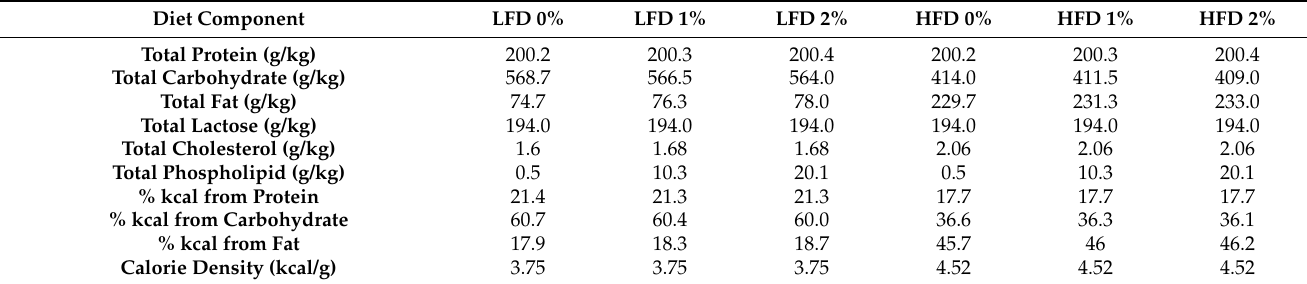
Table 2. Diet Composition by